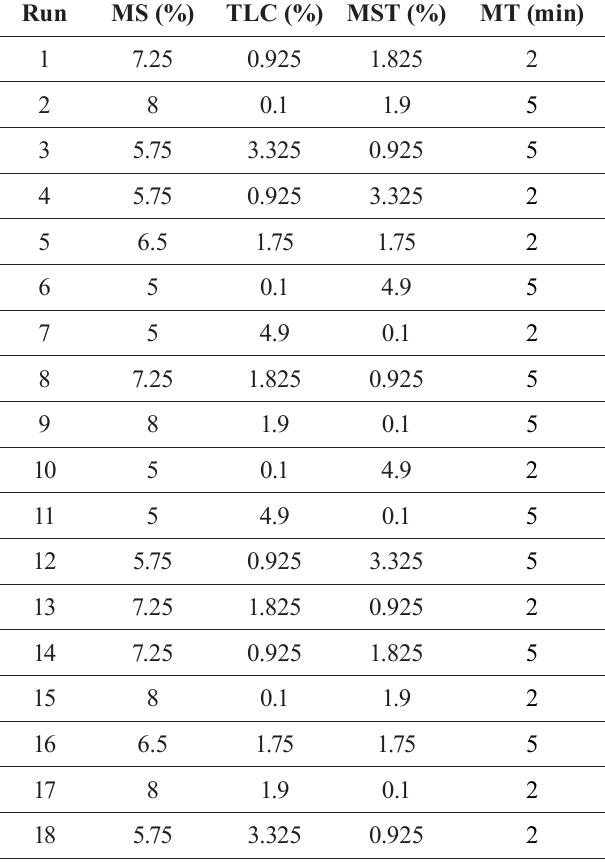
TABLE II - Input variables and their varied levels